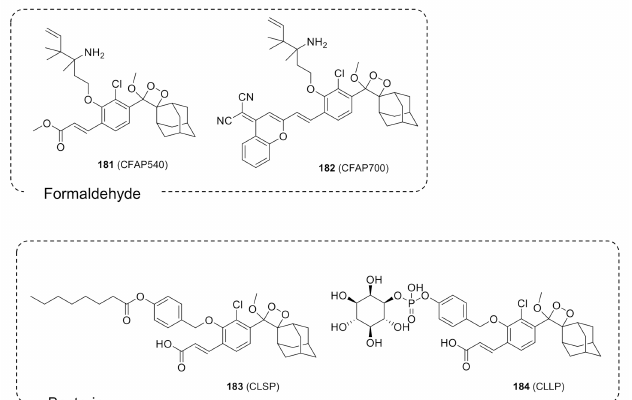
Figure 13. Chemiluminescence probes based on the caged strategy. ( a ) The design strategy of caged compounds. ( b ) Chemical structures of chemiluminescence